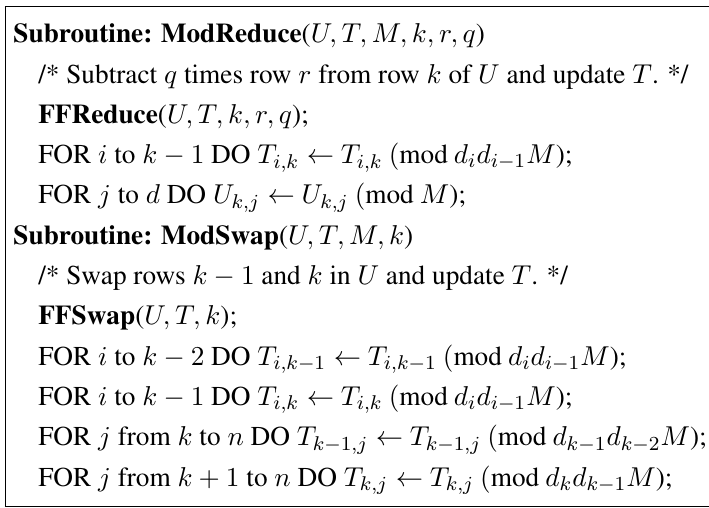
Figure 9. ModSubtract and ModSwap